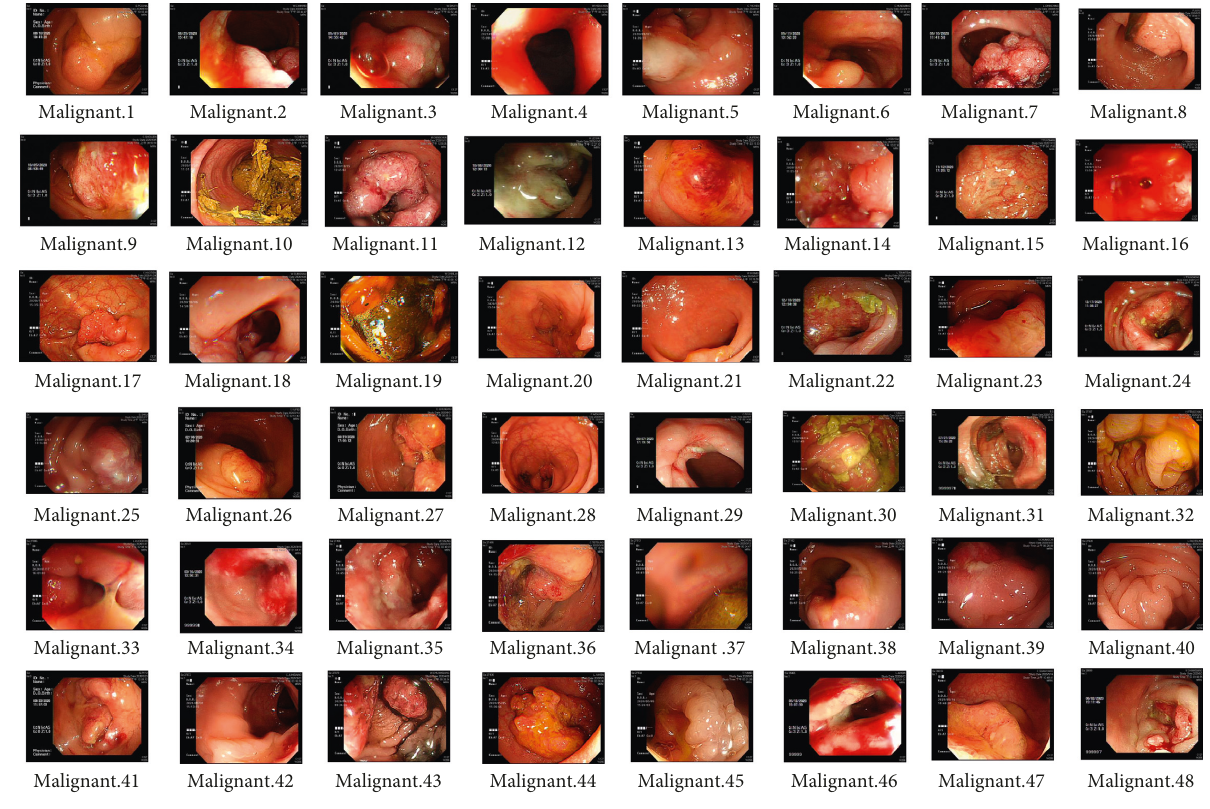
Figure 3: Malignant tumor. Table 1: Experimental setup. Table 2: CNN model parameter